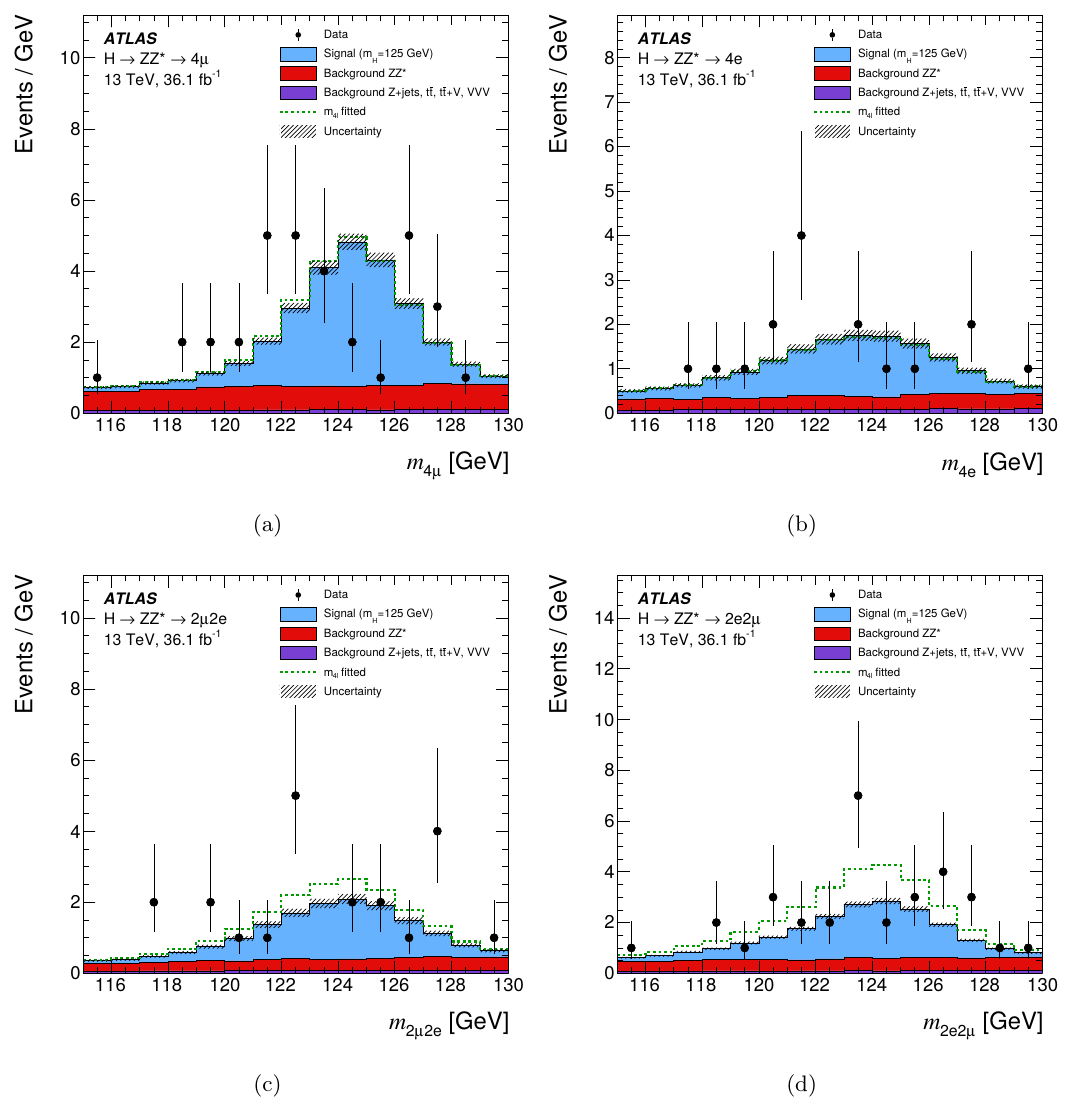
Figure 4. Template (cid:12)t of SM Higgs boson signal and background to the data for the inclusive distributions for the di(cid:11)erent decay channels (a) 4 (cid:22) , (b) 4 e , (c) 2 (cid:22) 2 e , (d) 2 e 2 (cid:22) . The error bars on the data points indicate the statistical uncertainty. The SM Higgs boson predictions are normalized to the cross sections discussed in section 3, while the backgrounds are normalized to the estimates described in section 6. The uncertainty in the prediction is shown by the dashed band. The dotted green line illustrates the best